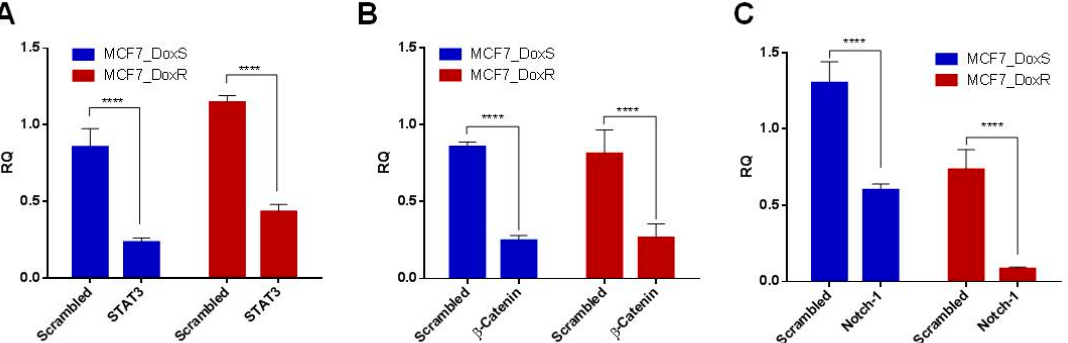
Figure 5. Gene-silencing e ff ect of each siRNA. The mRNA expression of the targeted genes in MCF7_DoxR and MCF7_DoxS cells after transfection with 50 nM of ( A ) STAT3; ( B ) β -catenin; and ( C ) Notch-1 siRNA for 72 h. Scrambled siRNA was used as a negative control for comparison. The 18srRNA gene was used as a housekeeping gene for Q-PCR. The data represent the average of three independent experiments ± SD. Statistical significance: Student’s t -test, **** indicates p < 0.0001.